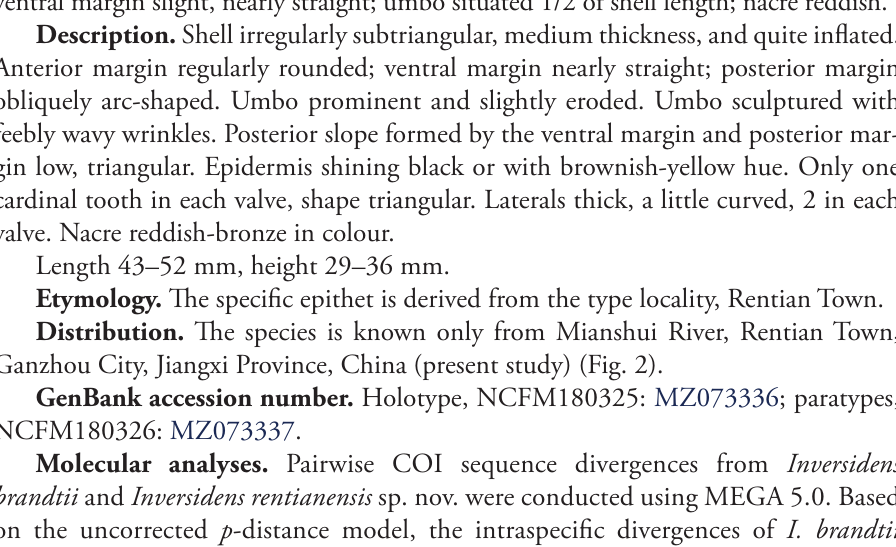
Type specimens. Holotype . China • Jiangxi Province, Ganzhou City, Rentian Town ( 壬田镇 ), Mianshui River (25.989557°N, 116.131333°E), 13 March 2018, coll. Xiongjun Liu (NCFM180325). Paratypes . Same data as holotype (NCFM180326- NCFM180328).